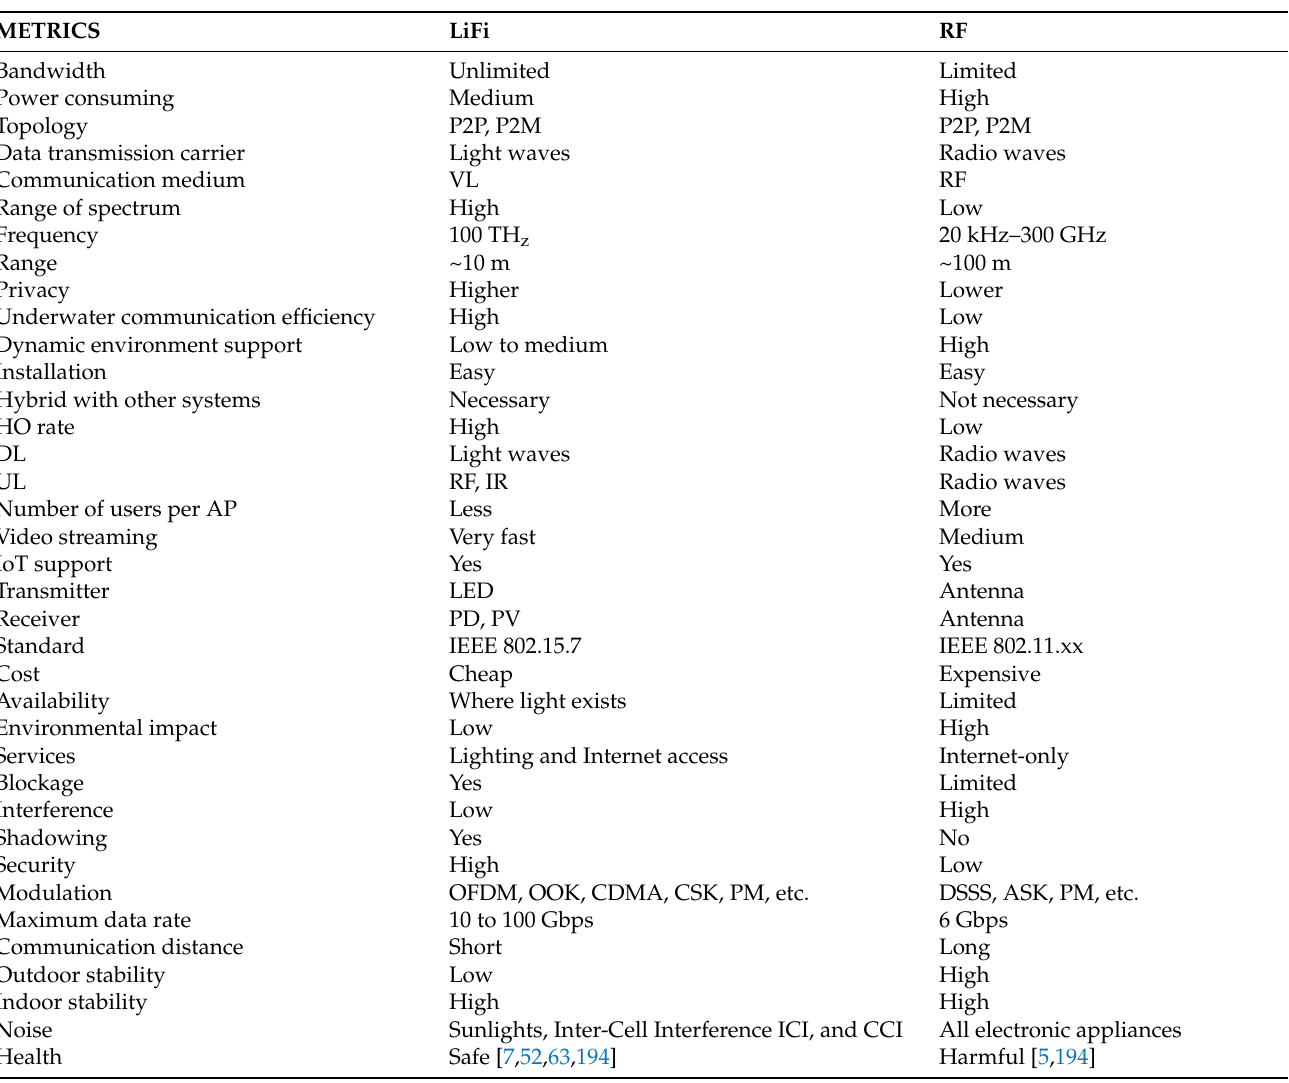
Table 5. LiFi and Rf comparison